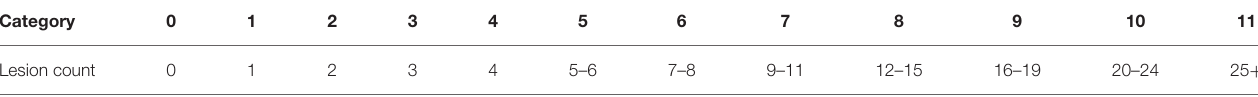
TABLE 2 | Since counting the lesions is increasingly more difficult with a higher lesion count, we created arbitrary categories accounting for this inaccuracy.